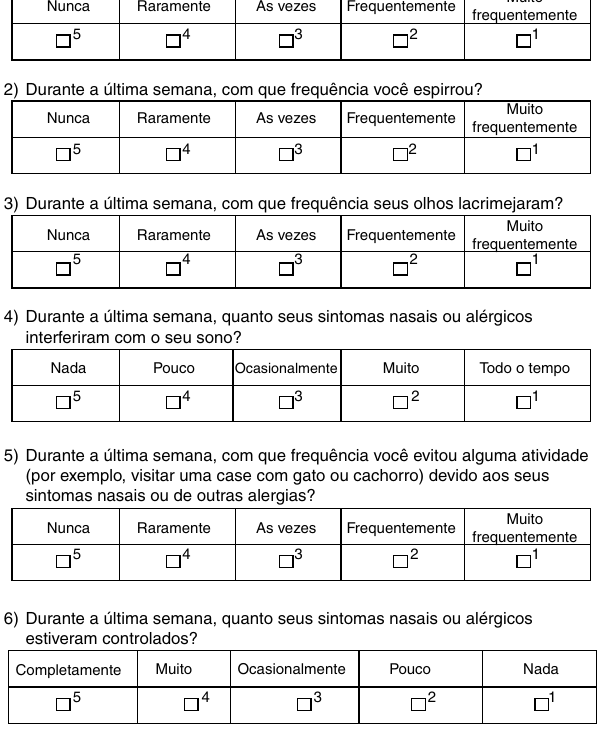
Figure 1 Translated version of the Rhinitis Control Assess- ment Test (RCAT) into the Portuguese language (Brazilian